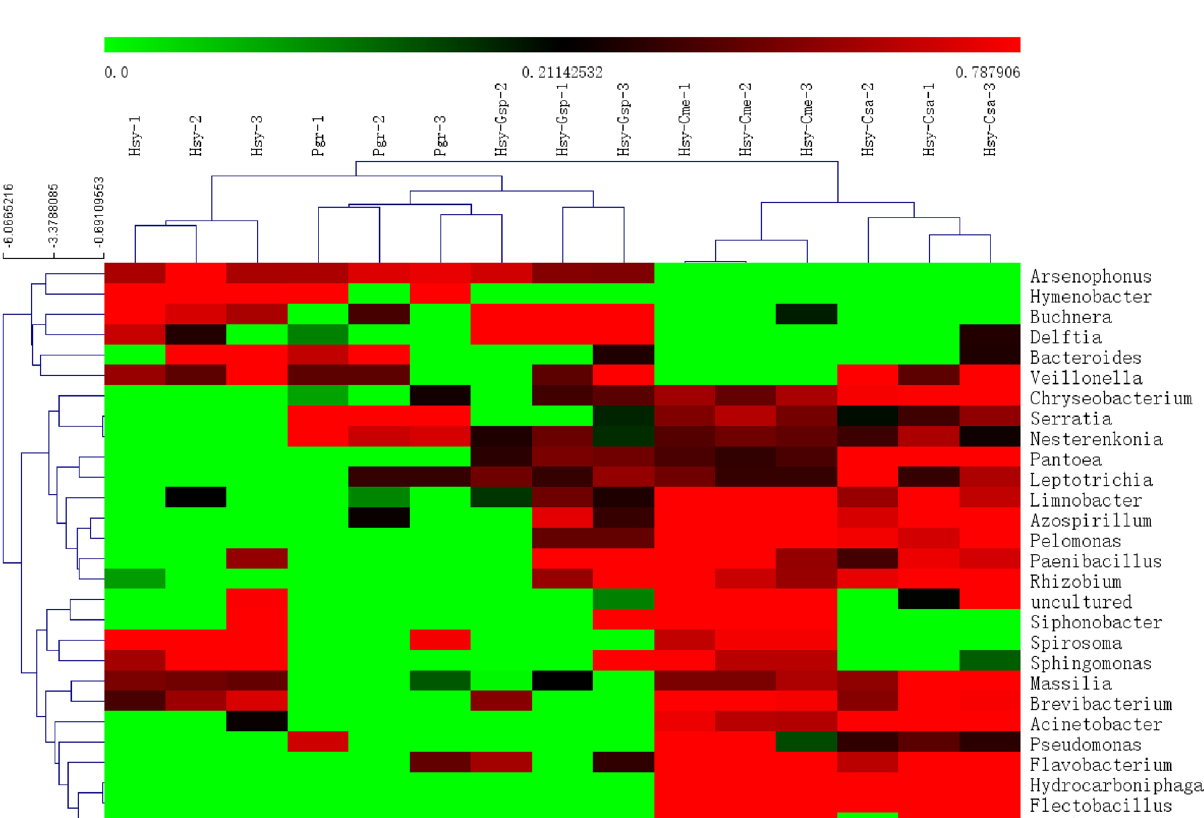
Figure 4. PCA of Hsy, Pgr, Hsy-Gsp, Hsy-Cme and Hsy-Csa. Each treatment is represented by 3 points corresponding to parallel experiments. Points with corresponding colors and shapes represent the same treatments.